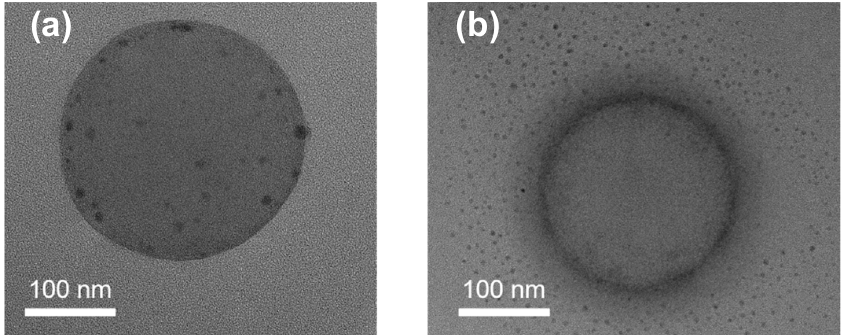
Figure 6. TEM images of ( a ) PSV@PSS-b-PNIPA@Ag and ( b ) PSV@PNIPA-b-PSS@Ag.